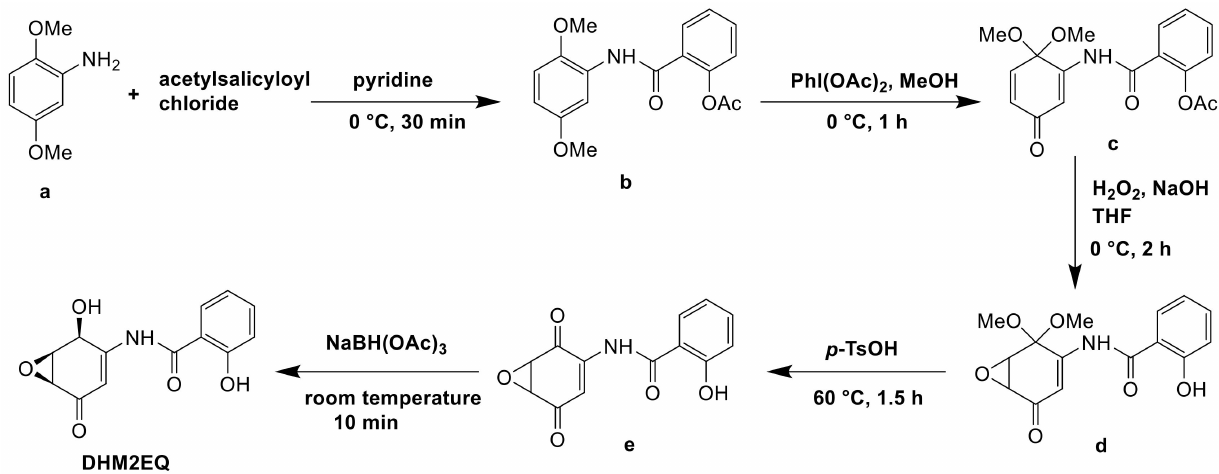
Figure 13. The chemical synthesis pathway of DHM2EQ